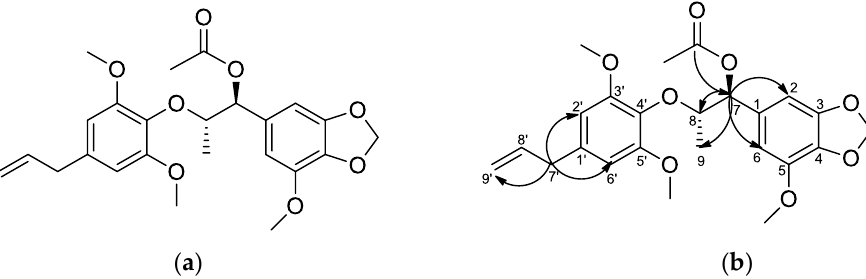
Figure 1. ( a ) Chemical structure and ( b ) key heteronuclear multiple bond correlation of compound 1